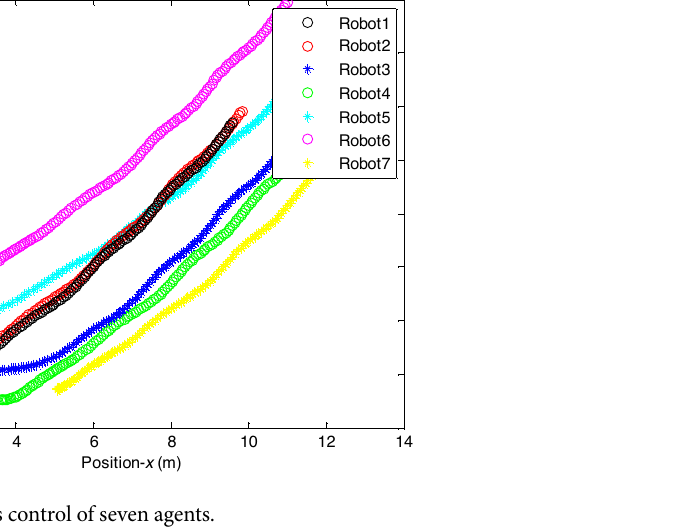
Figure 2. Consensus control of seven